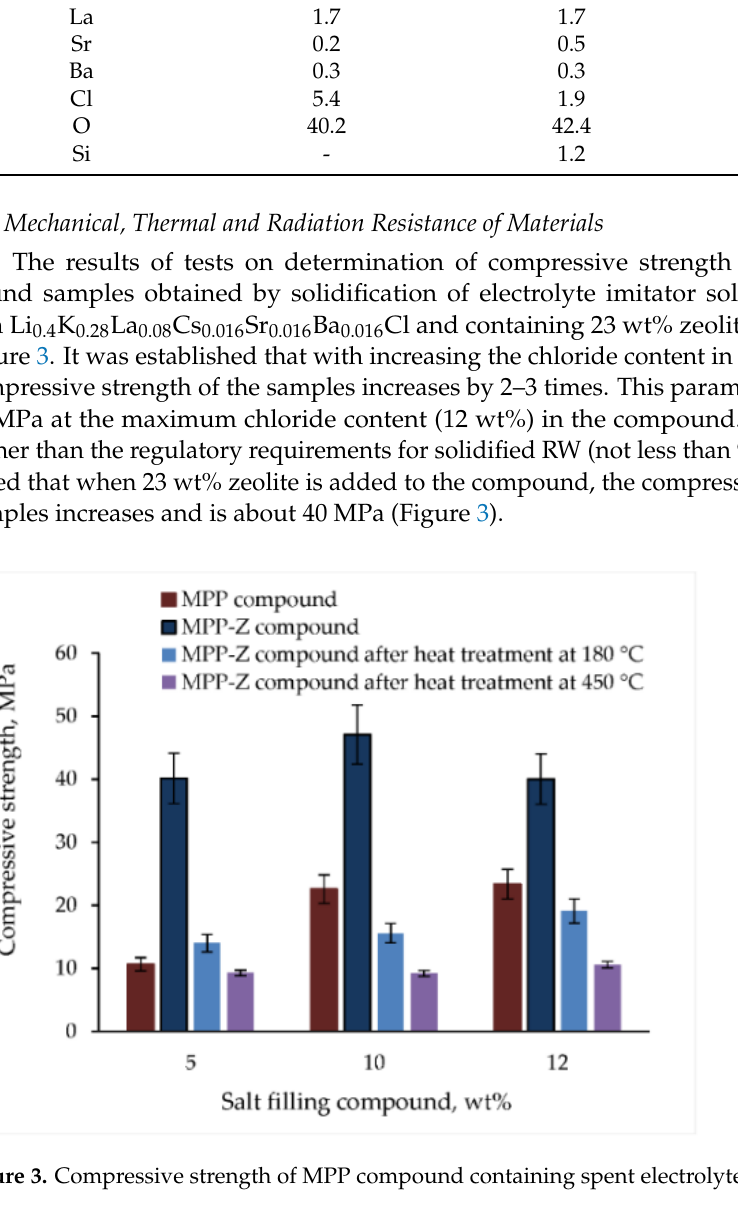
( b ) Figure 4. SEM image of ( a ) NAFP glass and ( b ) cleavage surface of the sample after heat treatment at 450 °C.